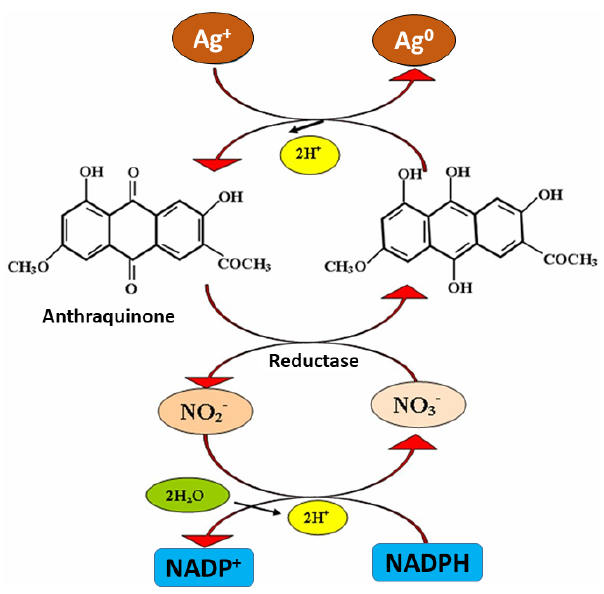
Figure 5. Possible anthraquinone-mediated hypothetical mechanisms for AgNPs synthesis (adapted and modified from [76]; an open access article).